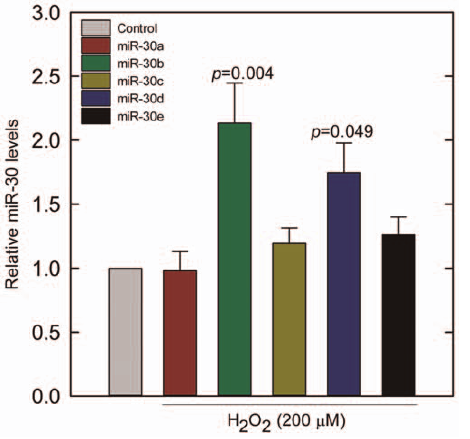
Figure 4. miR-30 targeting human catalase is sensitive to H 2 O 2 . Cultured ARPE-19 cells were treated with vehicle or 200 m M H 2 O 2 for 18 h before harvesting. The expression levels of miR-30 family members were determined by qRT-PCR using snRNA U5 as an internal control. Values are the means 6 SEM of relative changes over controls from four samples in each group after normalization to snRNA U5. H 2 O 2 increased the expression levels of miR-30b ( p =0.004) and miR-30d ( p =0.049) miRNAs as compared to the control.